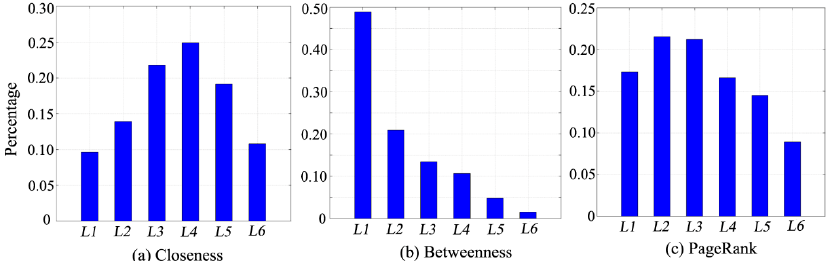
Figure 10. Statistical distribution of the six levels of groups. L1 represents the percentage of traffic analysis zones (TAZs) with level L1 in all TAZs.